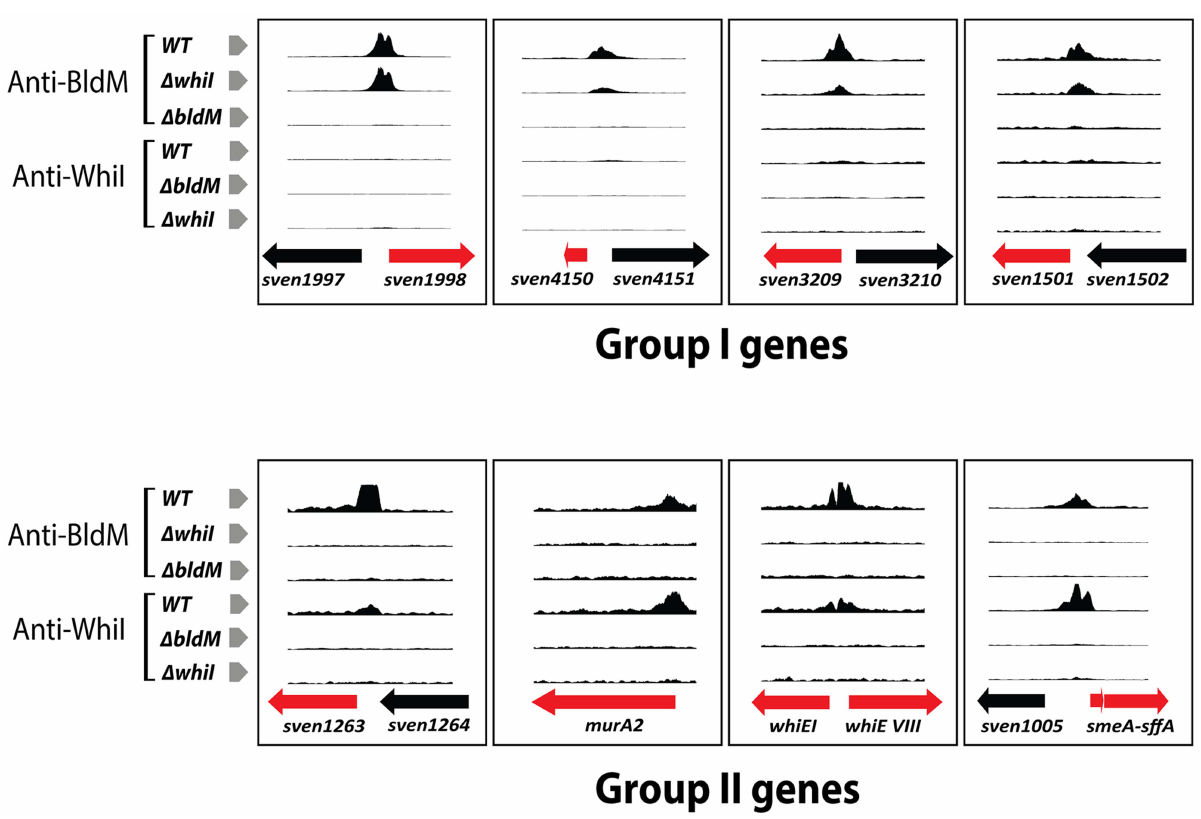
Figure 3. BldM and WhiI ChIP-Seq data for representative Group-I and Group-II promoters analysed in wild-type, D bldM and D whiI backgrounds. Only BldM binds at Group-I promoters and this occurs both in the wild type and in the D whiI mutant. Both BldM and WhiI bind at Group-II promoters in the wild type, but BldM binding depends on WhiI and vice versa . The genes shown in red are the targets genes.